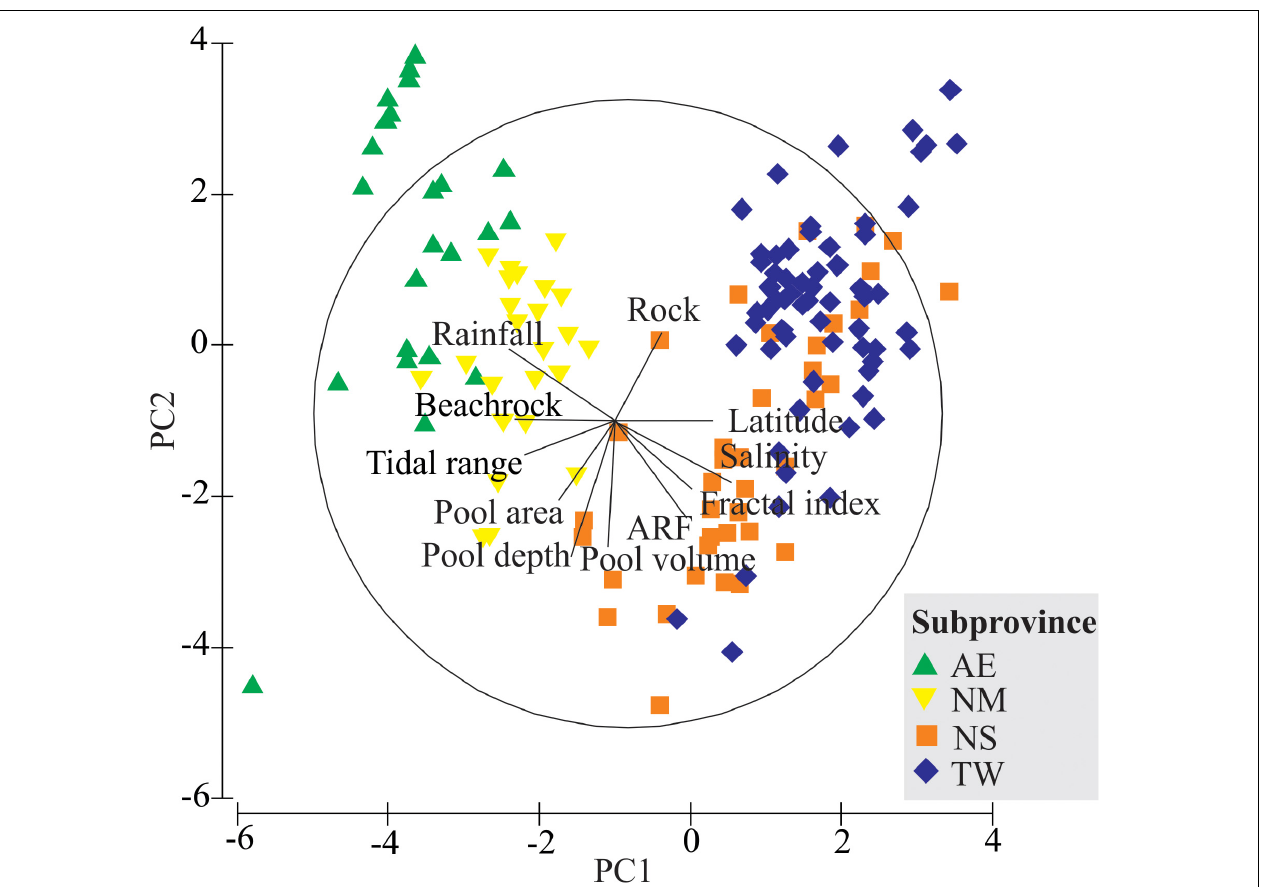
FIGURE 2 | Principal Components Analysis (PCA) ordination constructed from the environmental data ( Supplementary Tables S1, S2 ) of 149 tidepools sampled at 19 sites along the Brazilian coast. Only the variables with the highest loadings, positive or negative, are shown. The length and direction of the vectors represent the strength and direction of the relationship. The samples with no fish data ( N = 3) were omitted from the analysis. Subprovinces: AE, Amazon estuary; NM, Northern mangrove; NS, Northeastern semiarid; TW, Tropical warm.